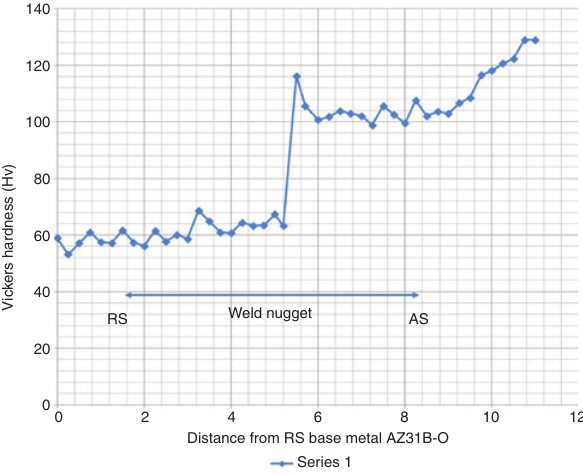
Figure 16: Vickers hardness plots of sample S5 obtained by micro